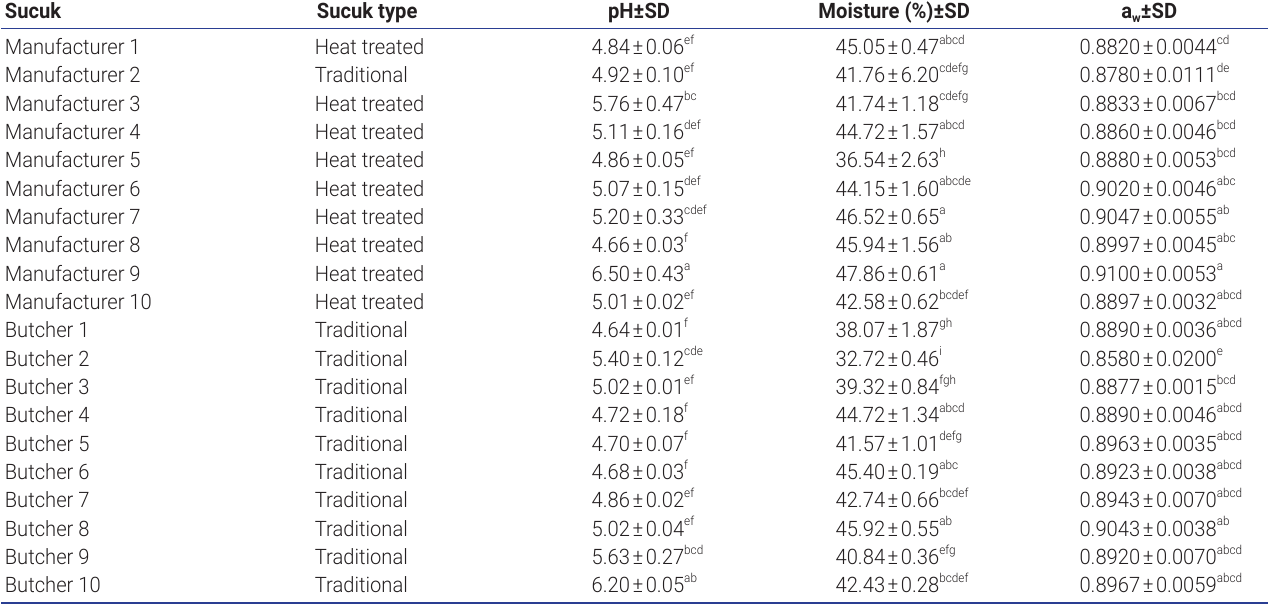
Table 3. Mean pH, moisture, and water activity values of a total of 60 sucuk samples